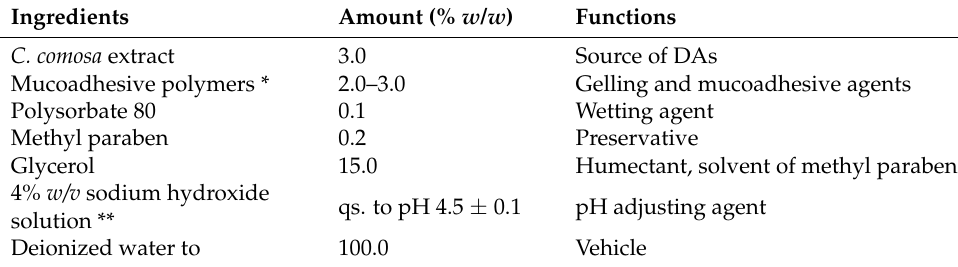
Table 1. General formulation compositions of C. comosa